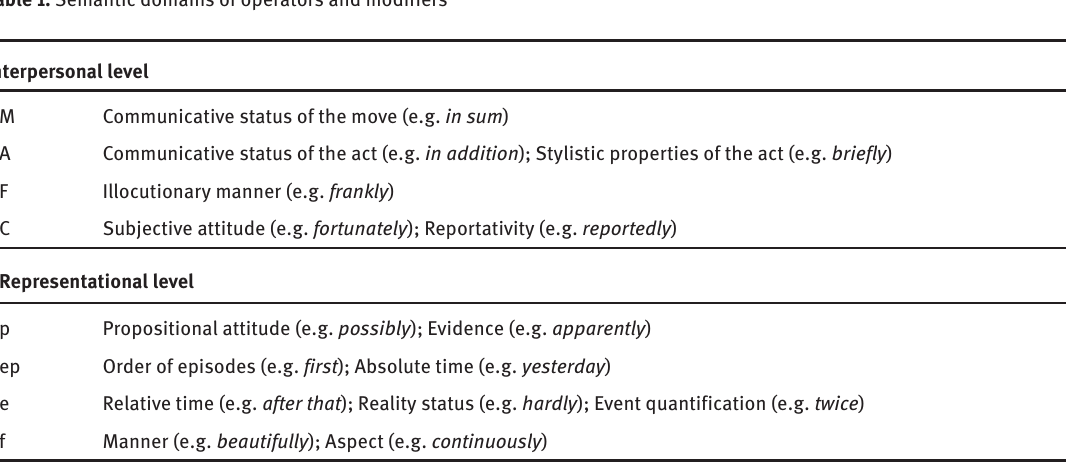
Table 1. Semantic domains of operators and modifiers